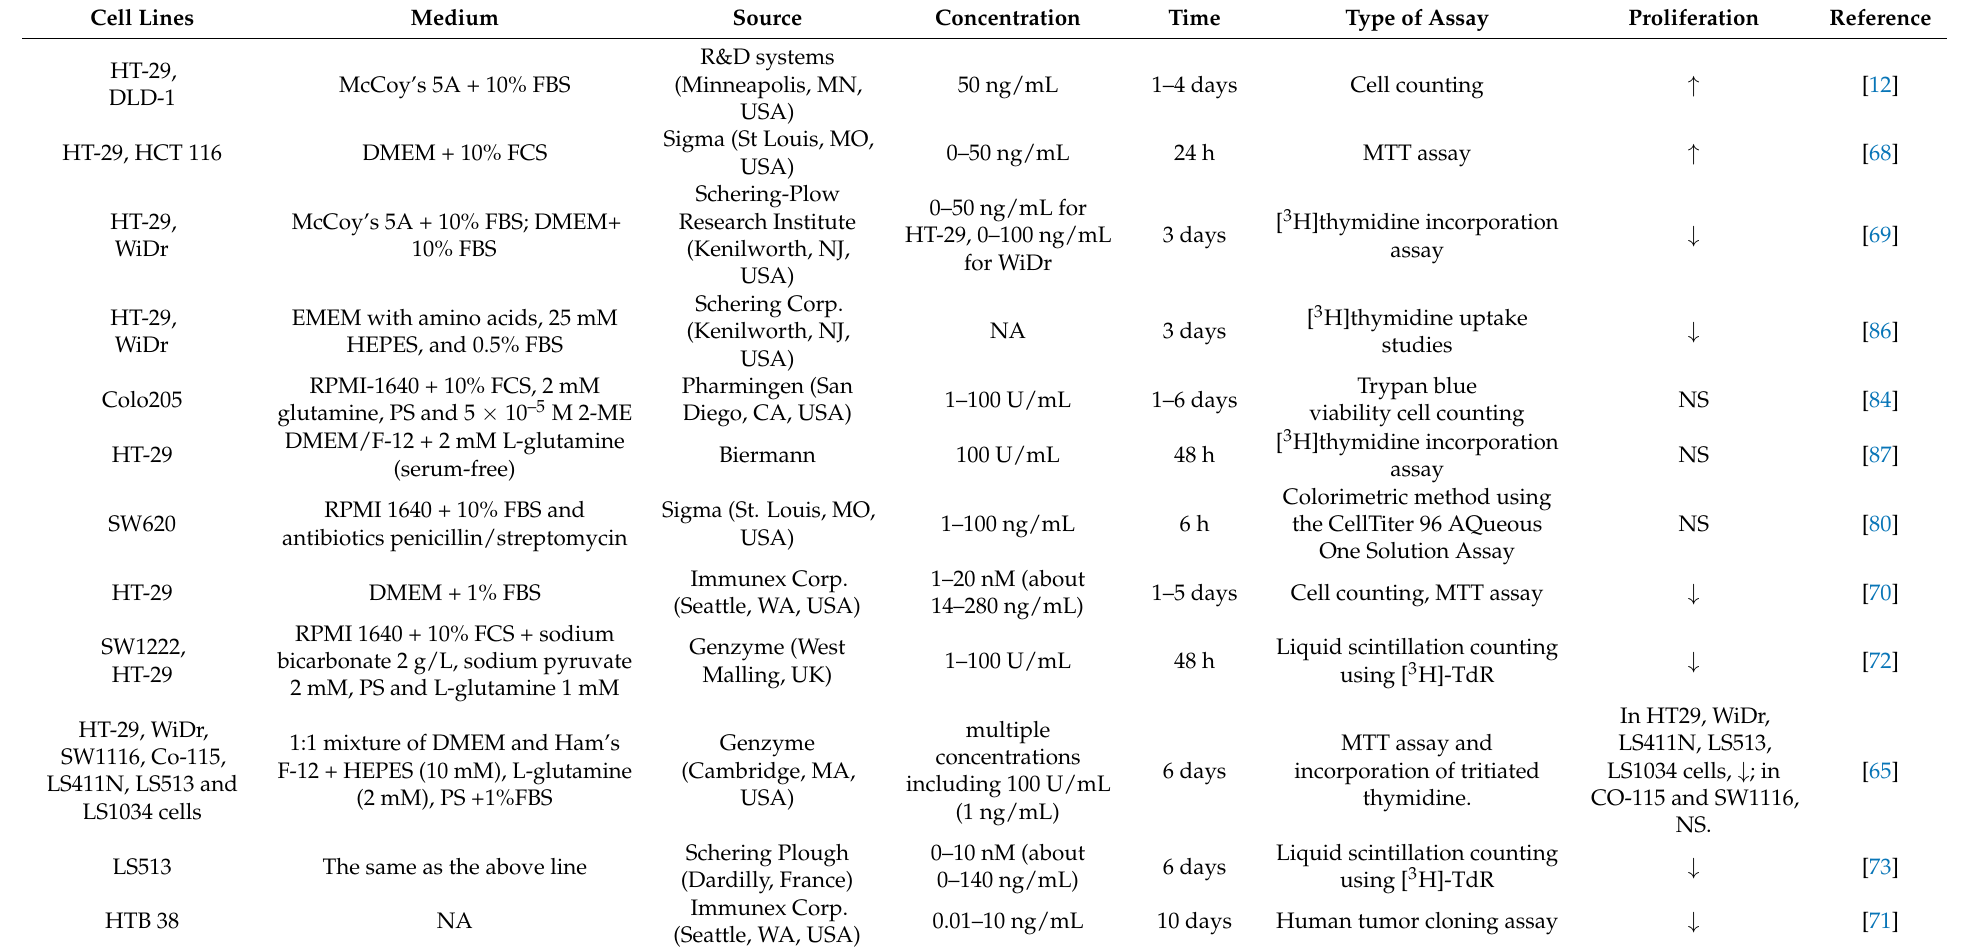
Table 1. Effect of IL-4 on human colon cancer cell